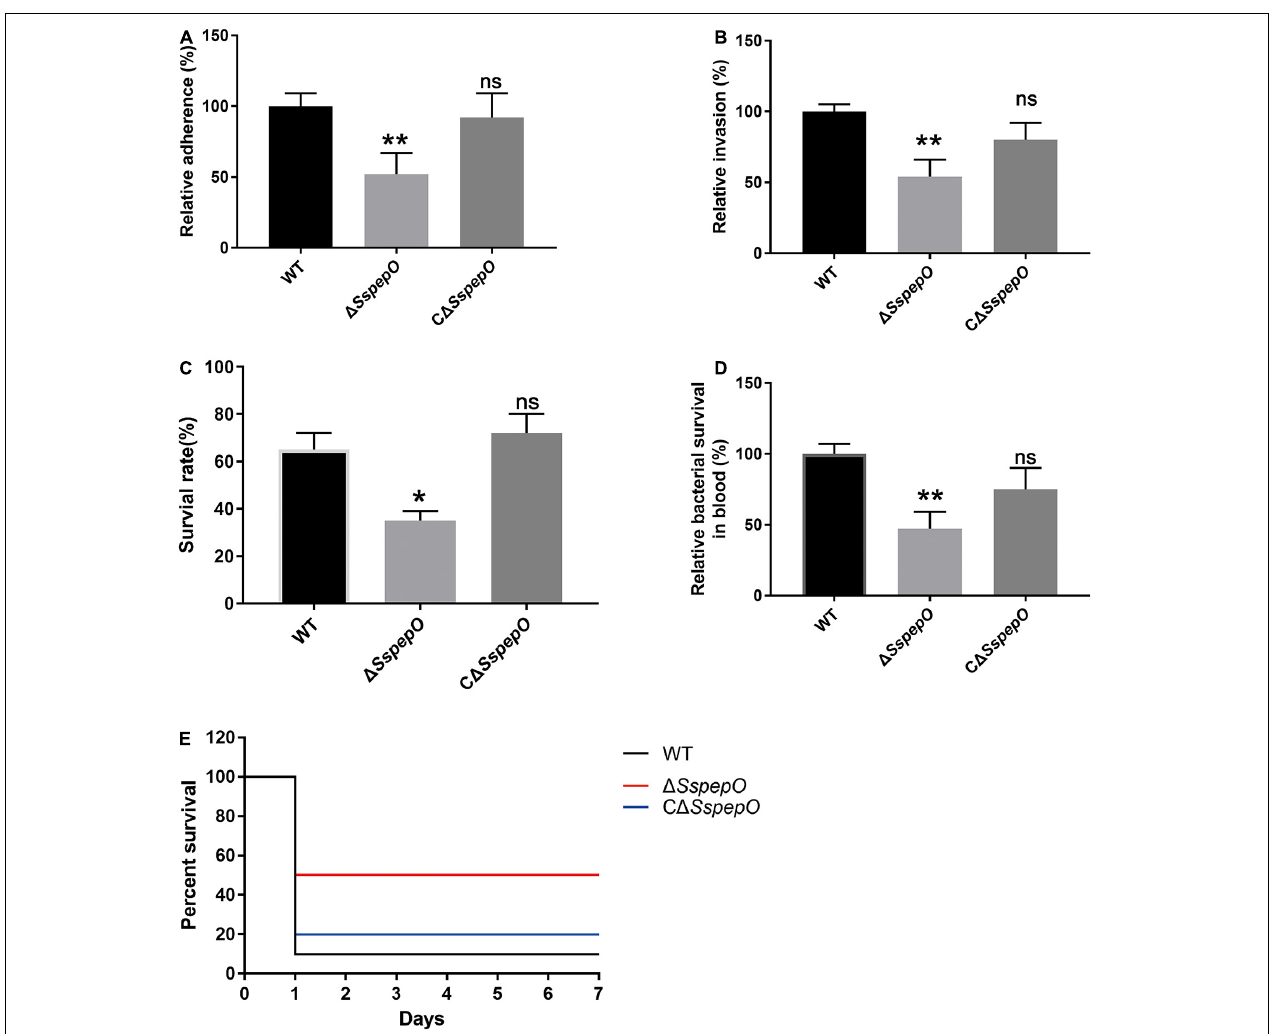
FIGURE 6 | Effect of S. suis SsPepO on adherence to and invasion of rat brain microvessel endothelial cell (RBMECs) and virulence. (A,B) Adherence to (A) and invasion of (B) WT S. suis , (cid:49) SspepO , and C (cid:49) SspepO were determined by counting the colony-forming units (CFU) per well obtained from sample aliquots plated onto blood agar plates after 2 h of infection. (C,D) WT S. suis , (cid:49) SspepO , and C (cid:49) SspepO strains were added to serum (C) or blood (D) , and their survival rates were calculated. These assays were repeated three times, and the results were represented as the mean ± SD. (E) Each S. suis strain (8 × 10 8 CFU) was